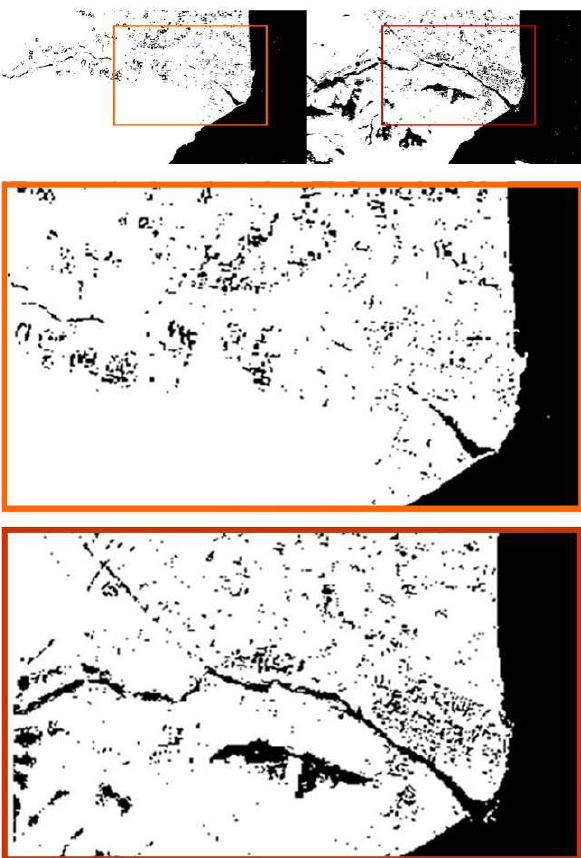
Figure 5 Normalization of significant areas for threshold of zero (0): the mage was classified for water applying the value of 0 to all negative NDVI values and the value of 1 to all positive results. The results show images of the area in May and Nov 2016 (above) and close-ups on the results in May 2016 (centre) and in Nov 2016